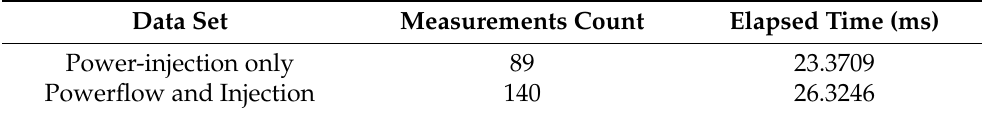
Table 15. Time delays ( t SE ) of unified WLS state